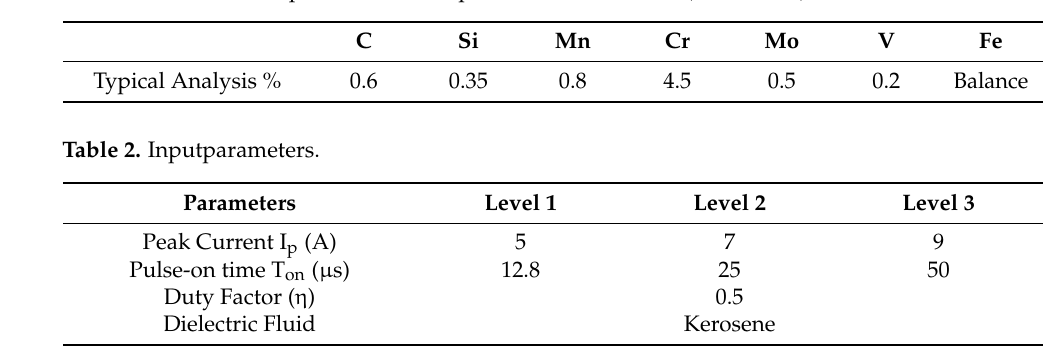
Table 1. Chemical composition of work piece material Calmax (Uddeholm).